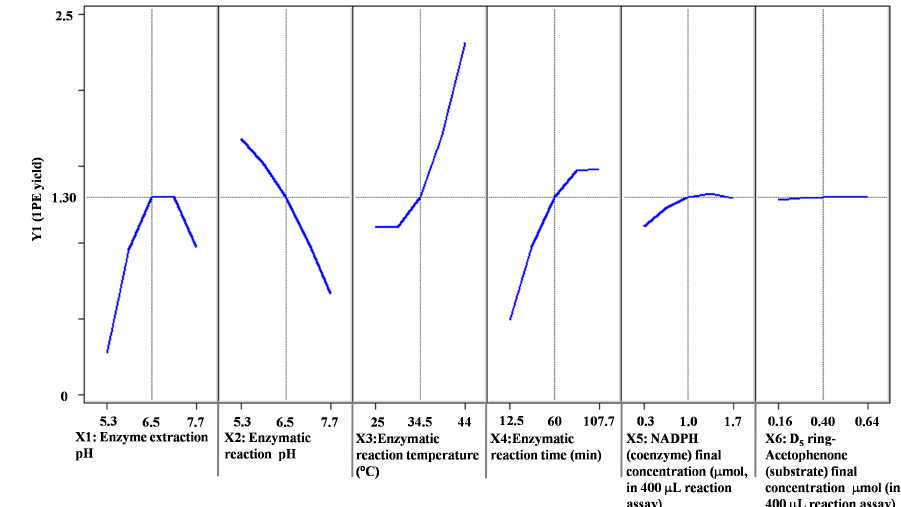
Figure 1. Prediction profilers of the effects of six variables (X1–X6) on 1PE yield. 1PE yield was determined by the peak area ratio of [ 2 H 5 ]ring-1PE to an internal standard (ethyl n -decanoate). Peak areas of the internal standard were calculated as the summation of m / z 88 and m / z 101. [ 2 H 5 ]ring-1PE peak areas were calculated as the summation of m / z 84, m / z 112, and m / z 127. Molecules 2017 , 22 , 131